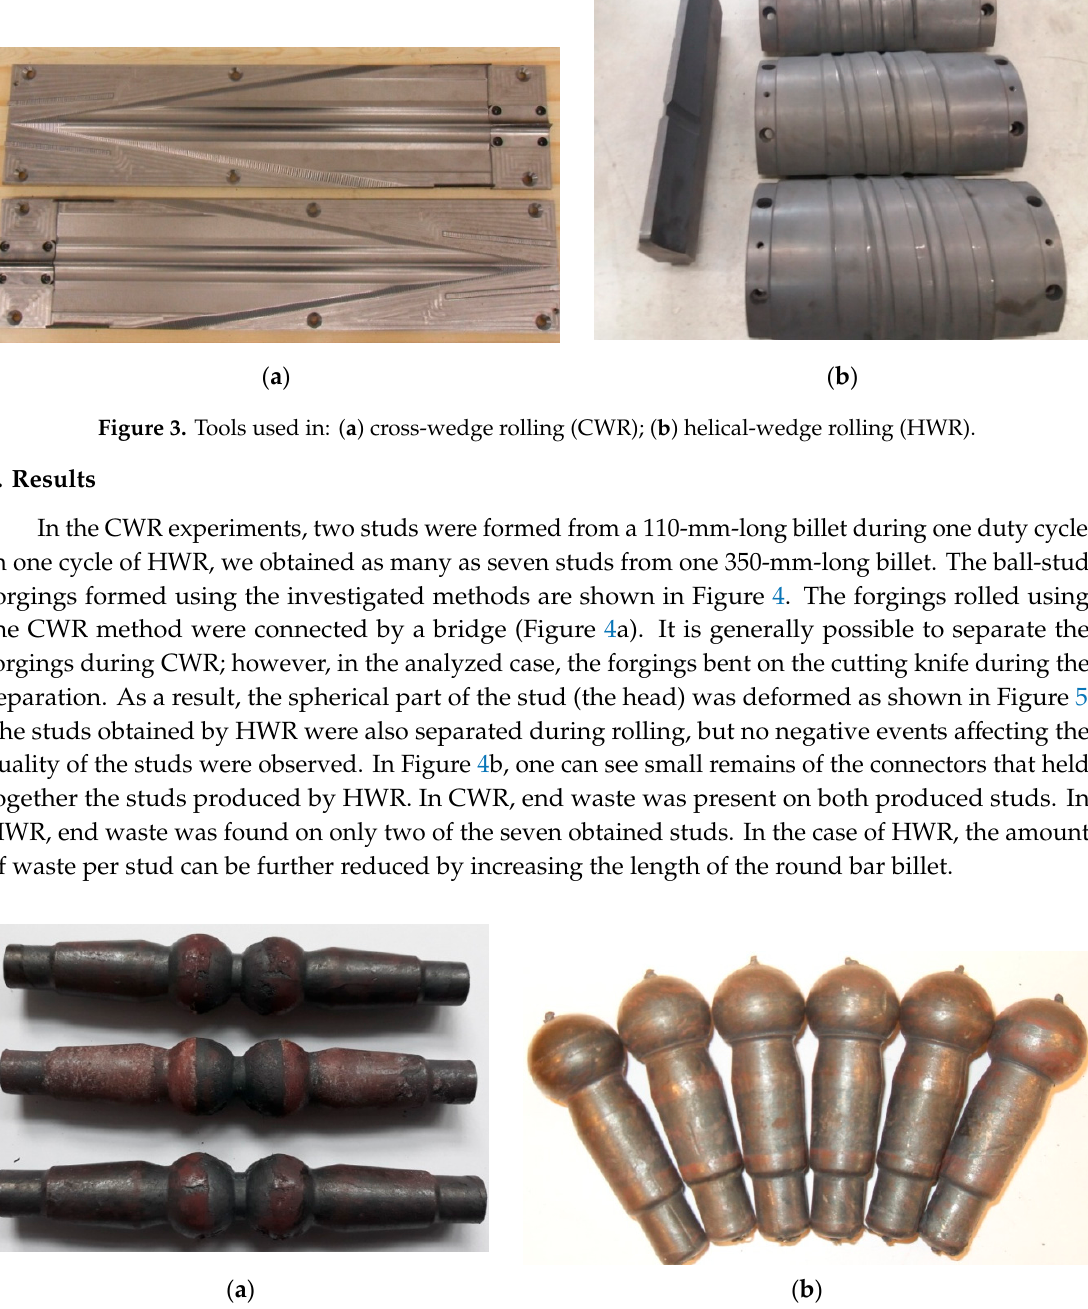
Figure 5. Ball studs after cutting during cross-wedge rolling (CWR).